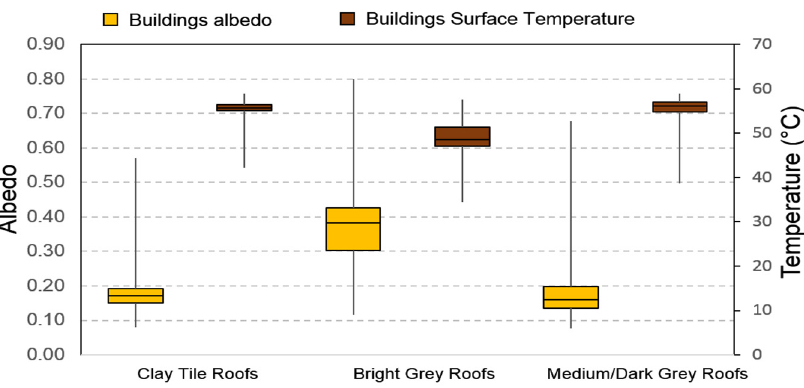
Figure 8. Box plot of albedo and temperature values for the three building classes identified on the WV3 image.